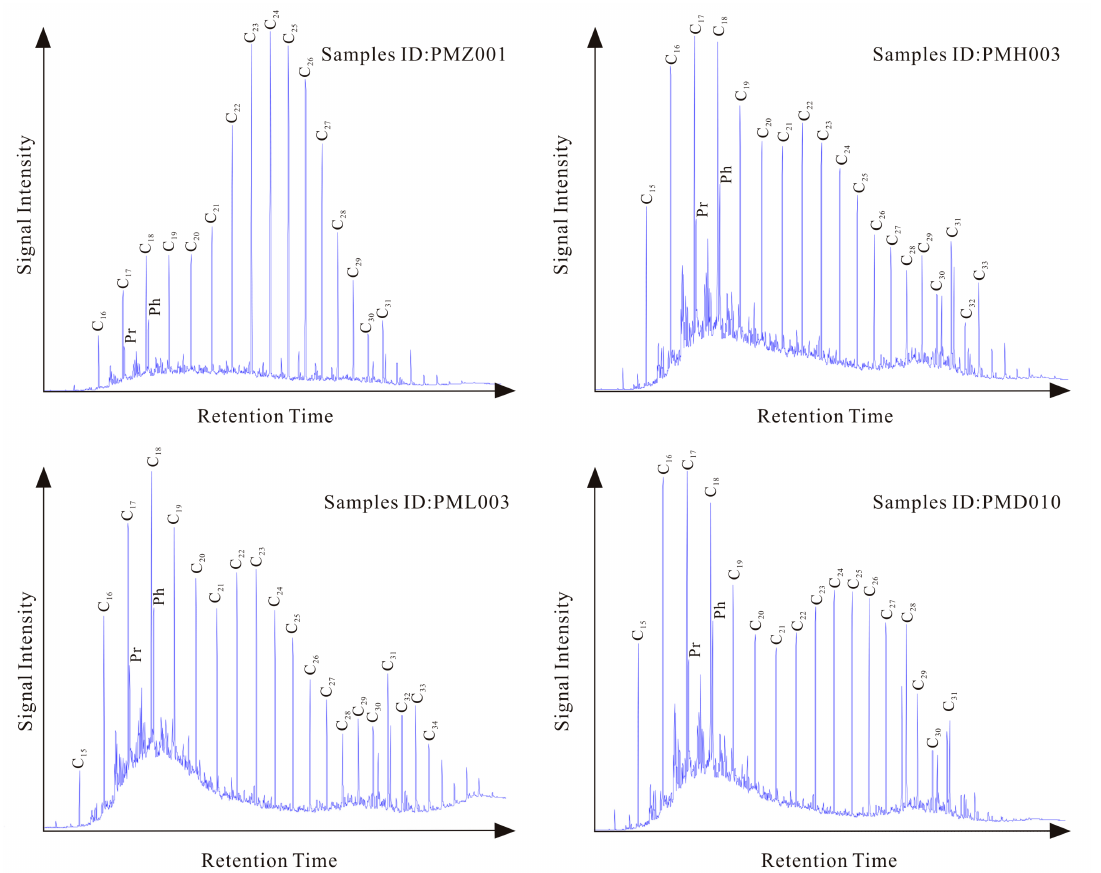
Figure 5. M/z85 mass fragment grams of saturated hydrocarbon